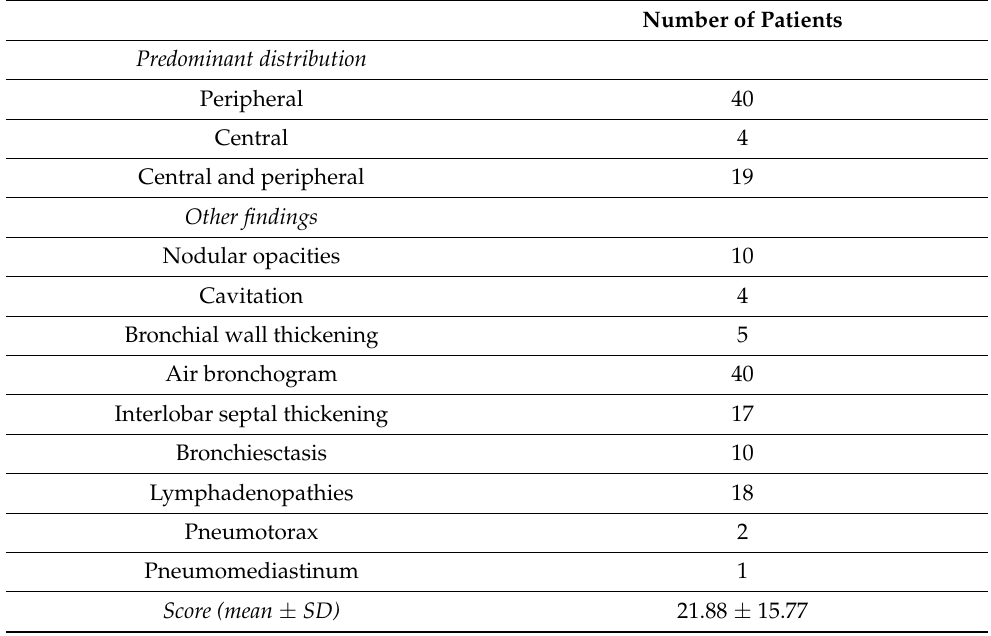
Number of Patients